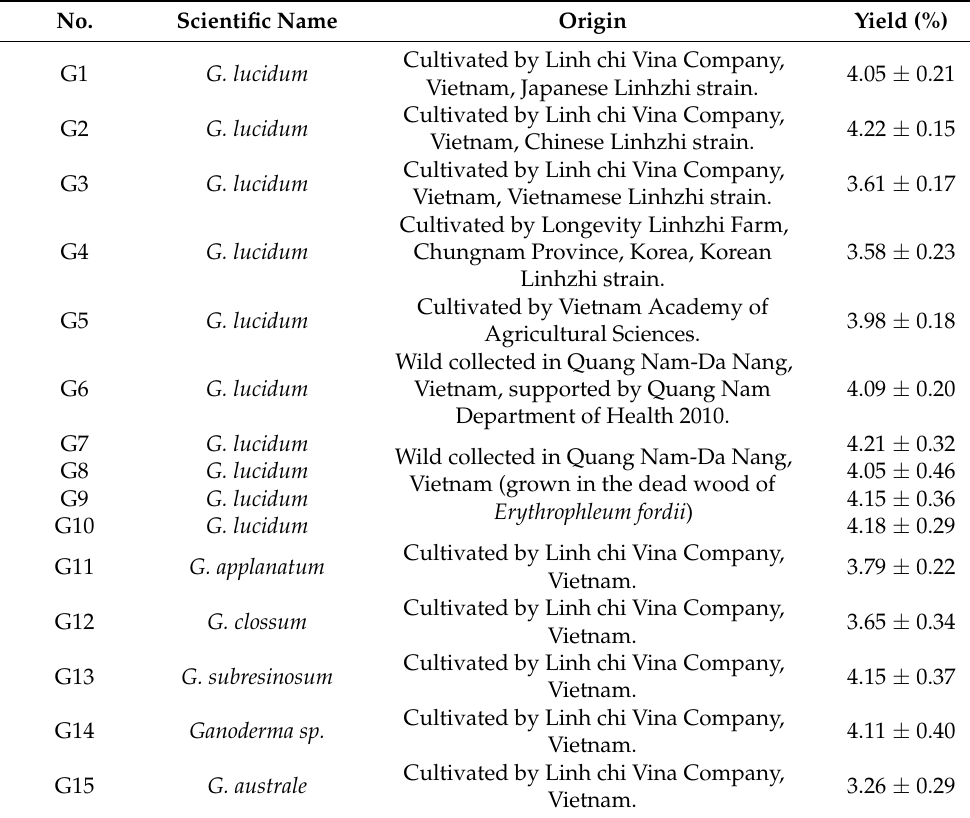
Table 1. Summary of the tested samples and percentage yield of the methanol extracts ( w / w ).